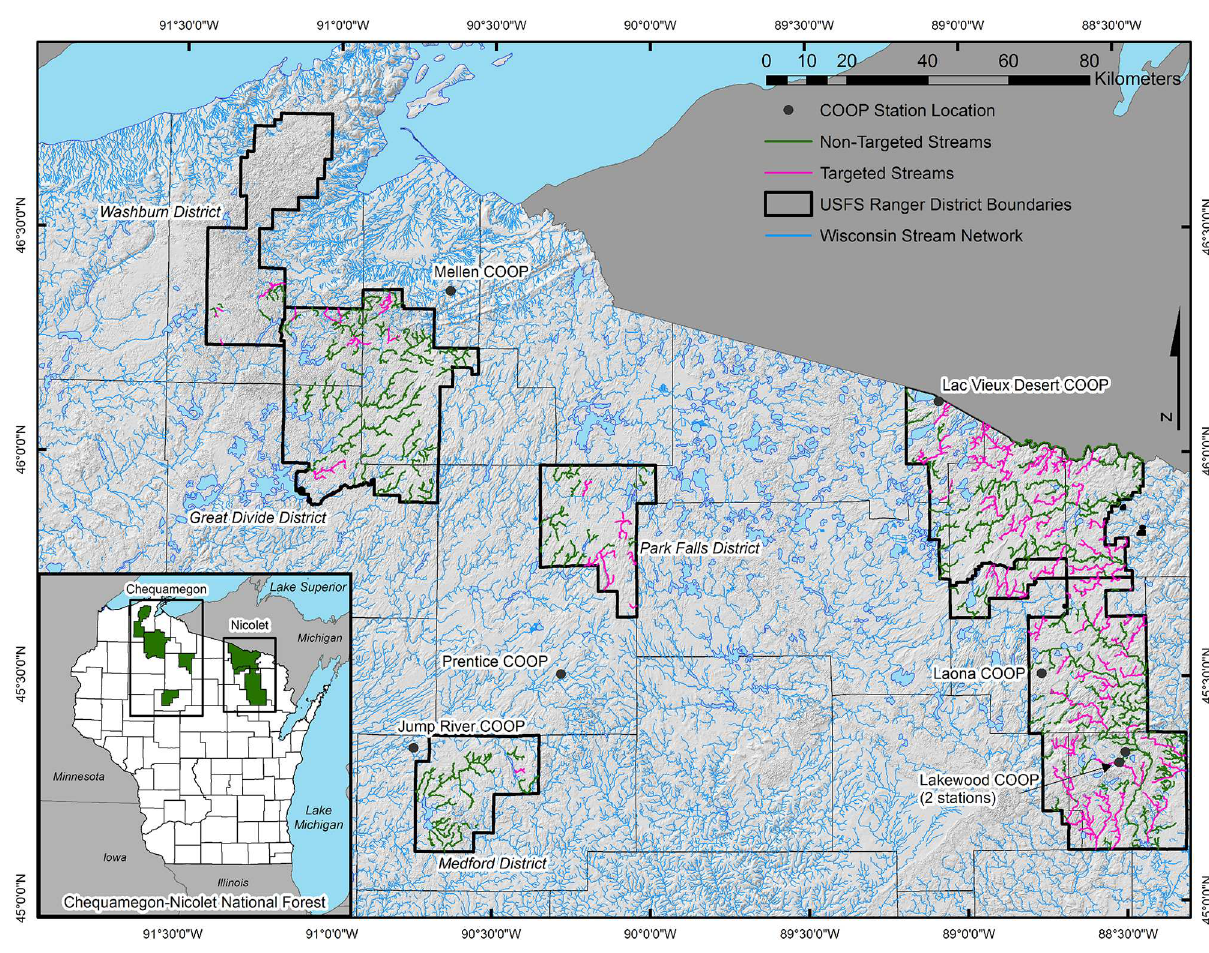
Fig 1. Location of the Chequamegon-Nicolet National Forest and the northern Wisconsin streamnetwork. Streams surveyedduring fall for active beaver colonieson the Chequamegon-Nicolet NationalForest. Targeted streams are in magentaand non-targeted streams are in green. The grey background for the stream network is the topographyof northernWisconsin as represented by a hillshademodel. Weather data were obtainedfrom the indicatedNationalWeather Service Cooperative Observer Program(COOP) weatherstations.